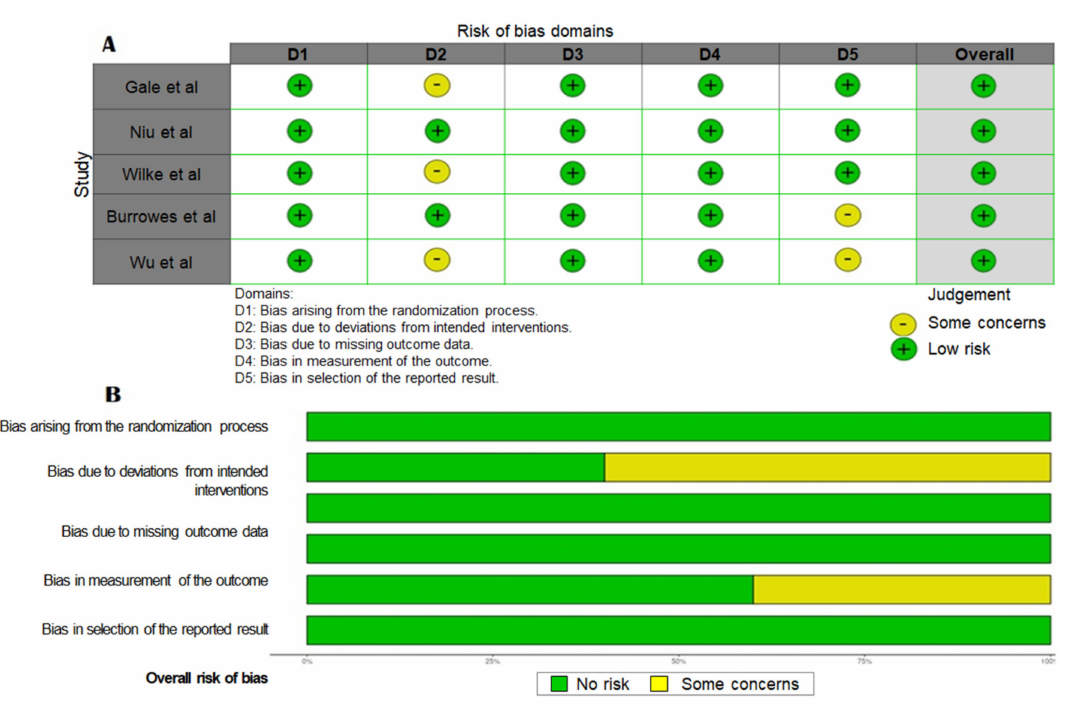
Figure 2. ( A ) Risk of bias assessment for individual studies (refs. [22–26]) included in the meta- analysis and ( B ) summary of the risk of bias of the selected